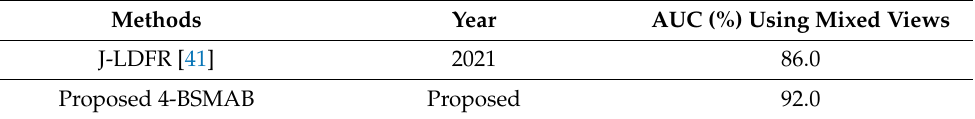
Table 16. AUC performance comparison between proposed and existing PGC approach on MIT